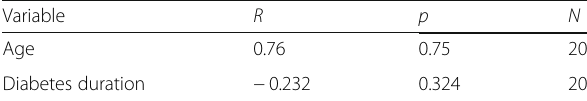
Table 4 Correlates of rTMS response Variable